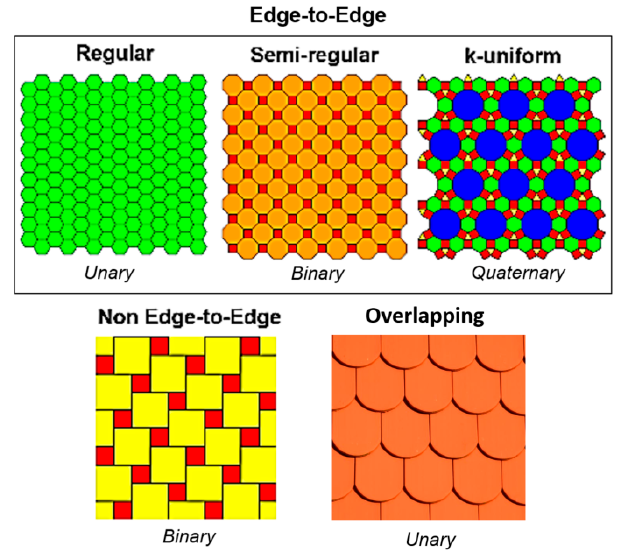
Figure 9. A selection of tessellation relationship schemes (Wikimedia Commons Attribution—Tomruen, following [36]).